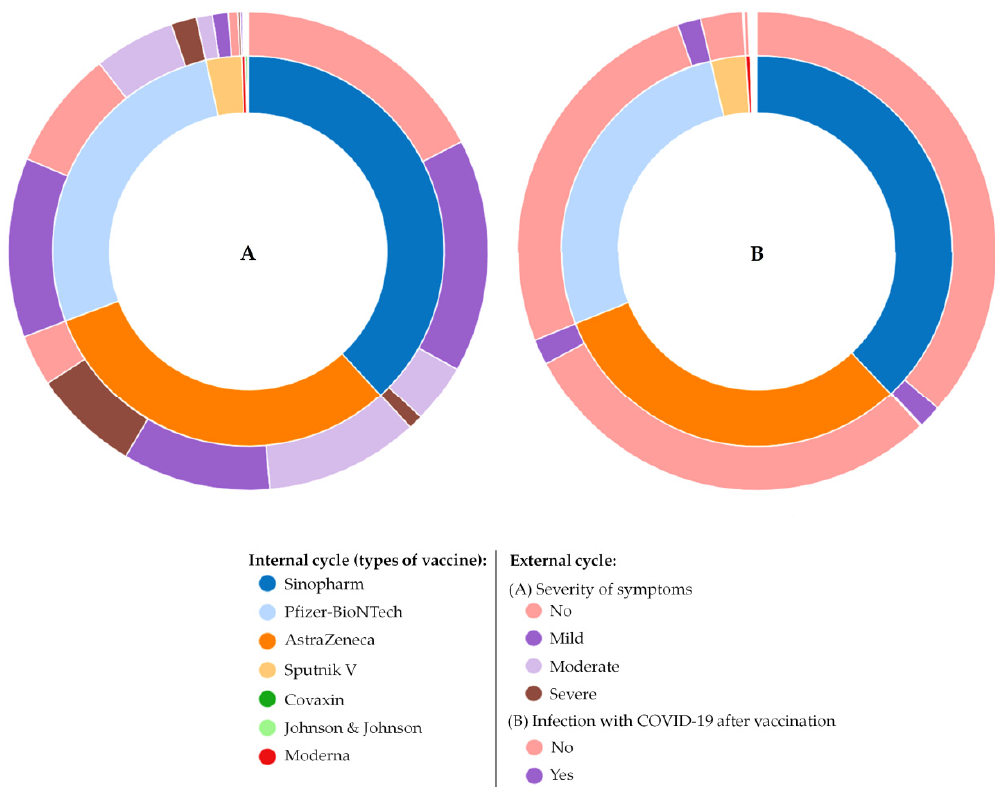
Figure 10. Sunburst illustrations represent the overall findings of the present study: COVID-19 vaccines that participants received, the severity post-vaccination side effects ( A ) and probability of post-vaccination infection ( B ).